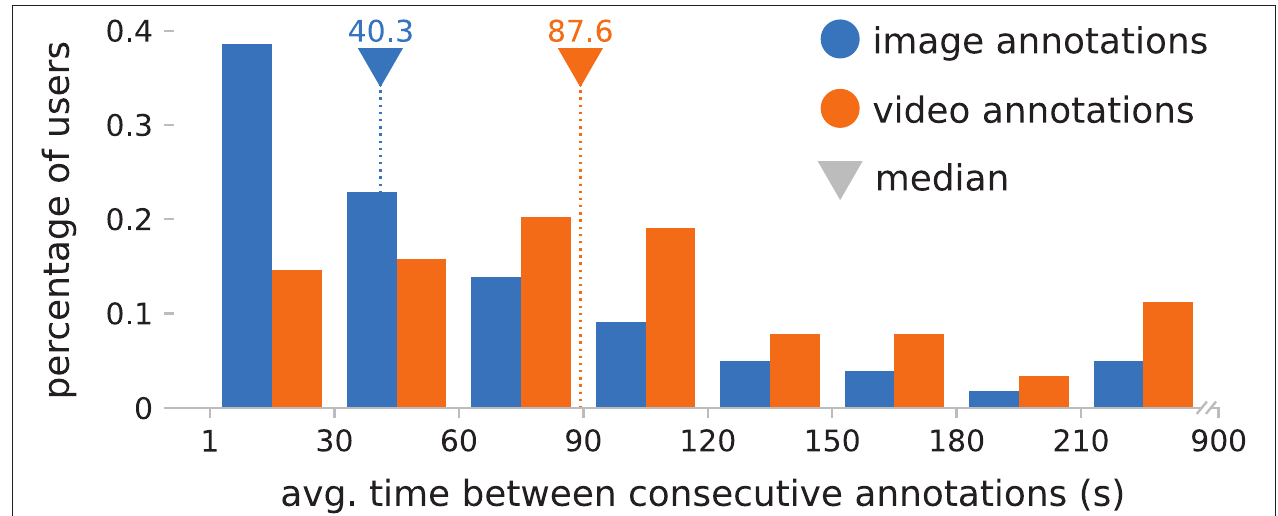
FIGURE 8 | Percentage of users grouped by the average time between any two of their consecutively created annotations, which are at least 1 s and at most 15 min apart. Image annotations created by using MAIA (see section 2.3) are excluded. The median of the average time it takes to create a video annotation is more than twice as high as the median for image